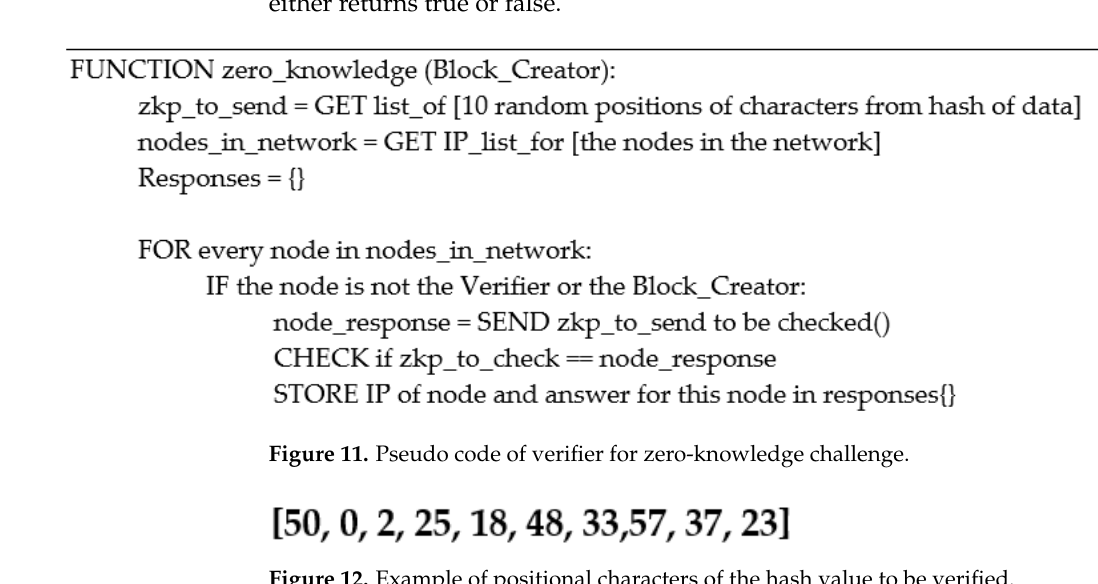
Figure 11. Pseudo code of verifier for zero-knowledge challenge. Figure 12. Example of positional characters of the hash value to be verified.